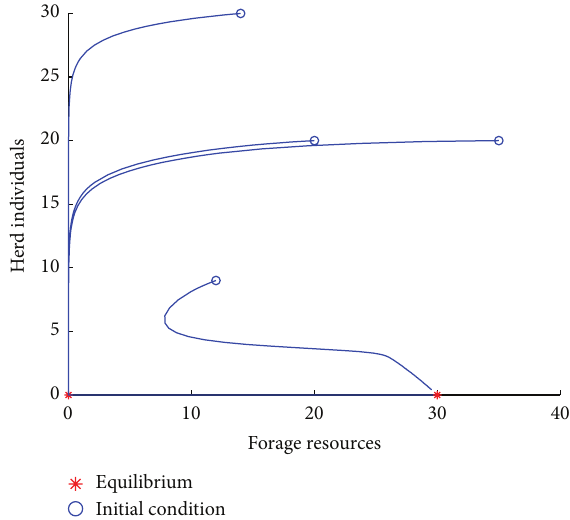
Figure 2: Phase portrait of System (1). Illustration of the local asymptotic stability of equilibrium 𝐸 0 = (0, 0) and equilibrium = (𝐾, 0) . These situations happen during transhumance; the 𝐸 1 pastoralists leave the area because of scarcity of forage resources or some local conditions. The rest of parameters in this case are given in Table 1, with 𝑟 01 = 200 kgDM/ha, 𝑟 02 = 55 kgDM/ha, = 80 kgDM/ha, and 𝐾 = 30 kgDM/ha such that 𝑟 > 0 𝑟 1